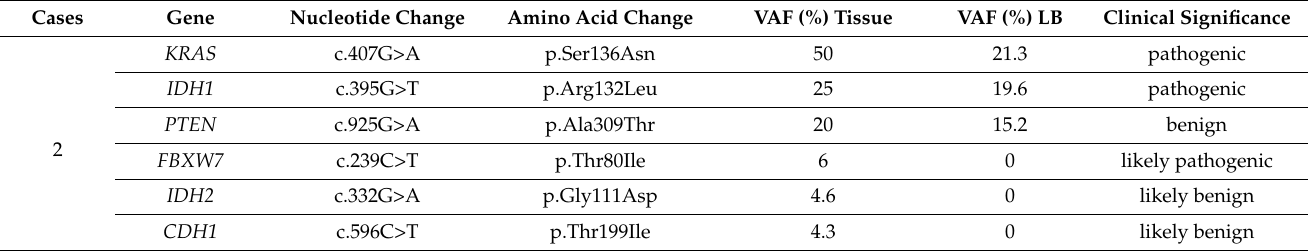
Table 3. Detected single-nucleotide